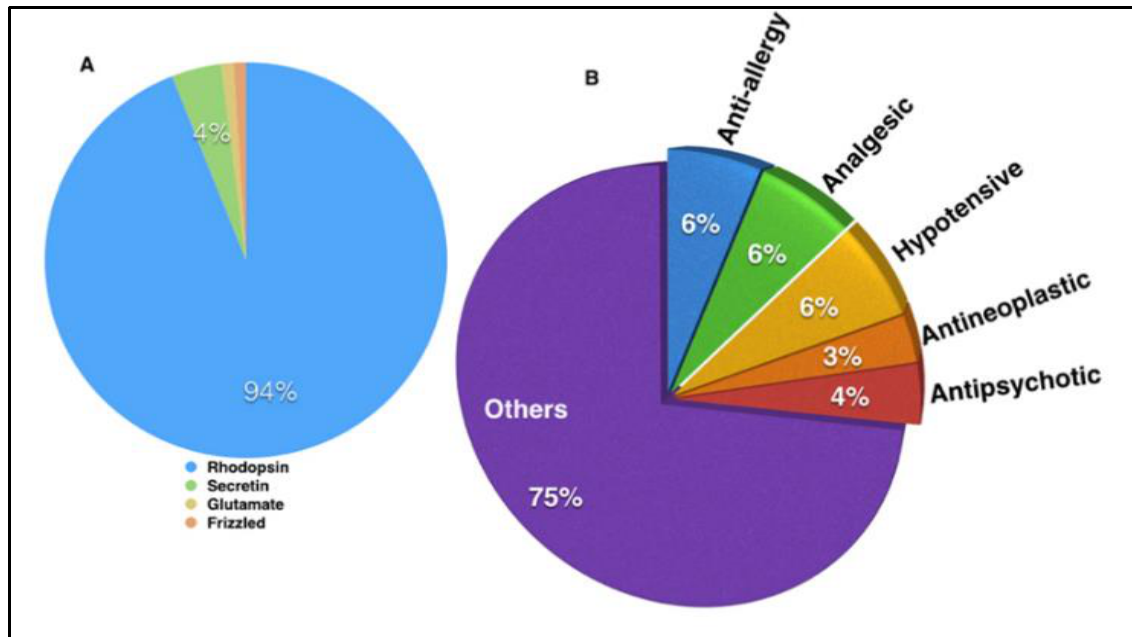
Figure 4. (A) The relative percentages of the four major subfamilies of G protein-coupled receptors. (B) The percentages of G protein-coupled receptors that target selected classes of conditions.Data were extracted from references 3 and